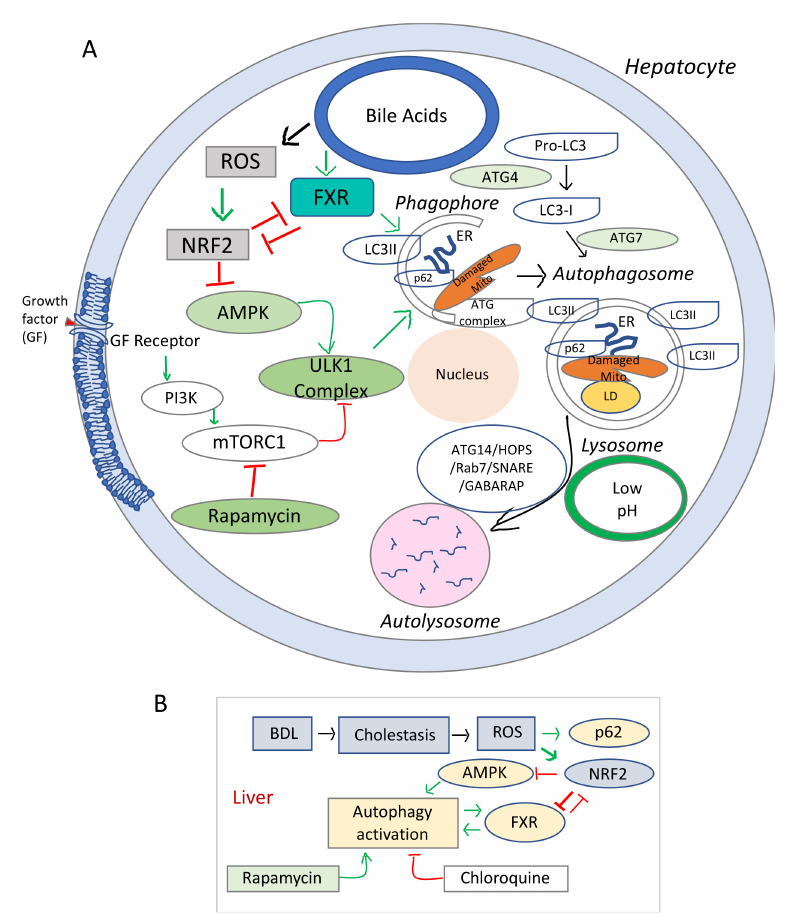
Figure 2. Diagram of signaling pathways involved in the dysregulation of autophagy and cell growth in cholestasis and liver fibrosis. ( A ), Schematic representation of the elements involved in the autophagy dysfunction in chronic oxidative stress. mTOR (mechanistic target of rapamycin) is a serine/threonine protein kinase, component of two distinct cellular complexes termed mTOR complex 1 (mTORC1) and mTORC2 where a multitude of signals such as nutrients, growth, energy are sensed and processed [114]. mTORC 1 downregulates autophagy (a catabolic process where macromolecules are sequestered in double membrane bound autophagosomes that fuse with lysosomes to allow their enzymatic breakdown). When there is sufficient energy, mTORC1 is active and through phosphorylation and destabilization of autophagy promoting complexes (ULK1 and other proteins), it ensures that autophagy is inhibited. During conditions of starvation, mTORC1 is inactive, it allows the phagosome to be formed. In addition, due to low energy level, AMPK gets activated and phosphorylates ULK1. Sequestome 1 (SQSTM1) or p62 is an active component of the autophagic process, and acts as a scaffold on lysosomal membranes for mTOCR1. During autophagy, p62 is incorporated into autophagosome and degraded, thus limiting mTORC1 activity. LC3 or microtubule- associated proteins 1A/1B light chain 3B is a biomarker of autophagosome. ( B ), Diagram of the interaction of cholestasis-induced ROS with autophagy in hepatocytes. While stimulating p62 and phagosome formation, ROS inhibit AMPK-mediated energy production needed for the autophagic flux, via NRF2 upregulation. Stimulation of autophagy by rapamycin and overexpression of FXR in autophagy-deficient cells counteract the effects of NRF2 reducing ROS-mediated hepatic